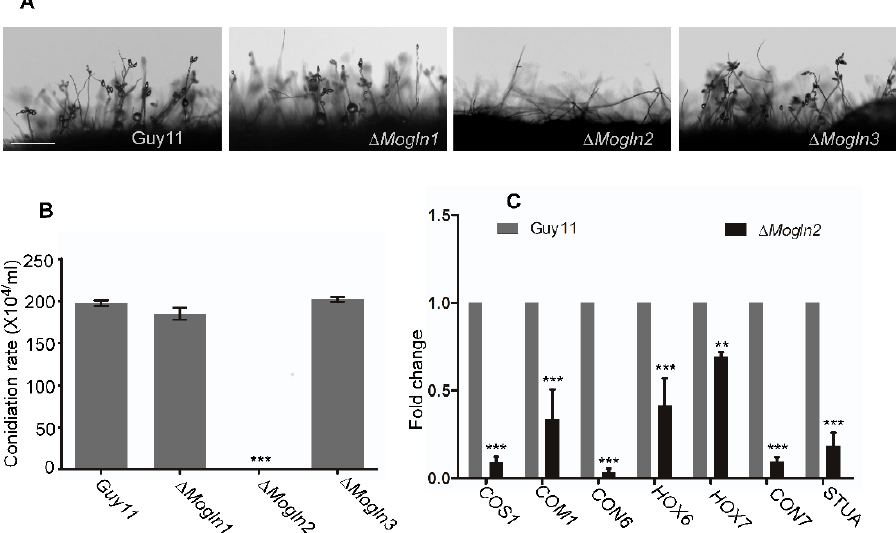
Figure 6. MoGln2 plays an important role in asexual reproduction in M. oryzae . ( A ) Represents conidiophore development and spore formation capacity of strains cultured on rice bran medium for 10 days. Bar, 10 μ m. ( B ) Graph showing quantification of spores from Guy11, Δ Mogln1 , Δ Mogln2, Δ Mogln3 strains on rice bran medium. The Δ Mogln2 mutant failed to produce spores. ( C ) Quantitative RT-PCR analysis showing the expression of conidiation-related genes in the WT and Δ Mogln2 mutants. The expression was normalized actin gene (MGG_03982). Results are means obtained from three independent replicates. Error bars represents standard deviations. Asterisks indicate statistically significant differences (**, p < 0.01; ***, p < 0.001; one-way ANOVA was applied to analyze data with Tukey’s multiple-comparison test in GraphPad Prism 8).